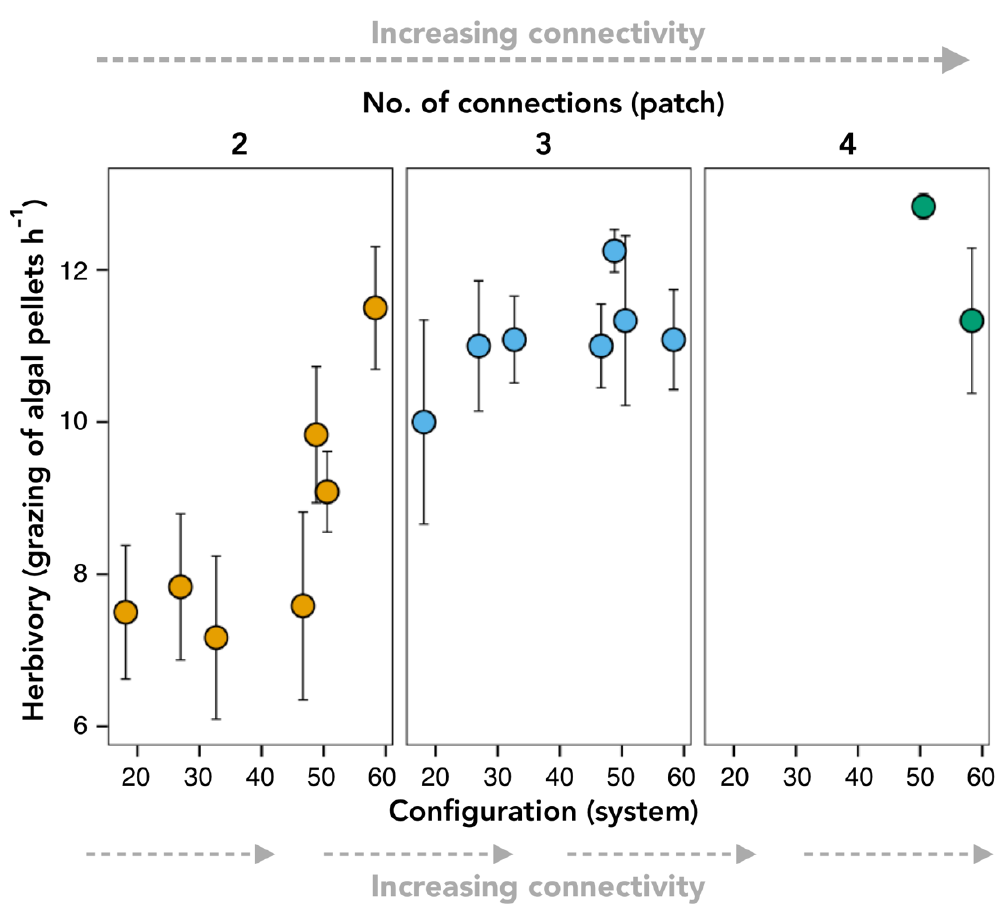
Figure 2. Herbivory during a pulse disturbance and the interaction between patch- and system-scale responses to an increase in connectivity. Herbivory is the mean (SE) number of algal pellets consumed after a 1 h period (colours indicate no. of connections at the patch scale). No. of connections (patch) is the number of connections that linked disturbed patches to neighbouring patches (disturbed patches had a minimum of two connections). Configuration (system) is a modified value for closeness centrality at the system scale, which quantifies a commonly used dimension of connectivity.